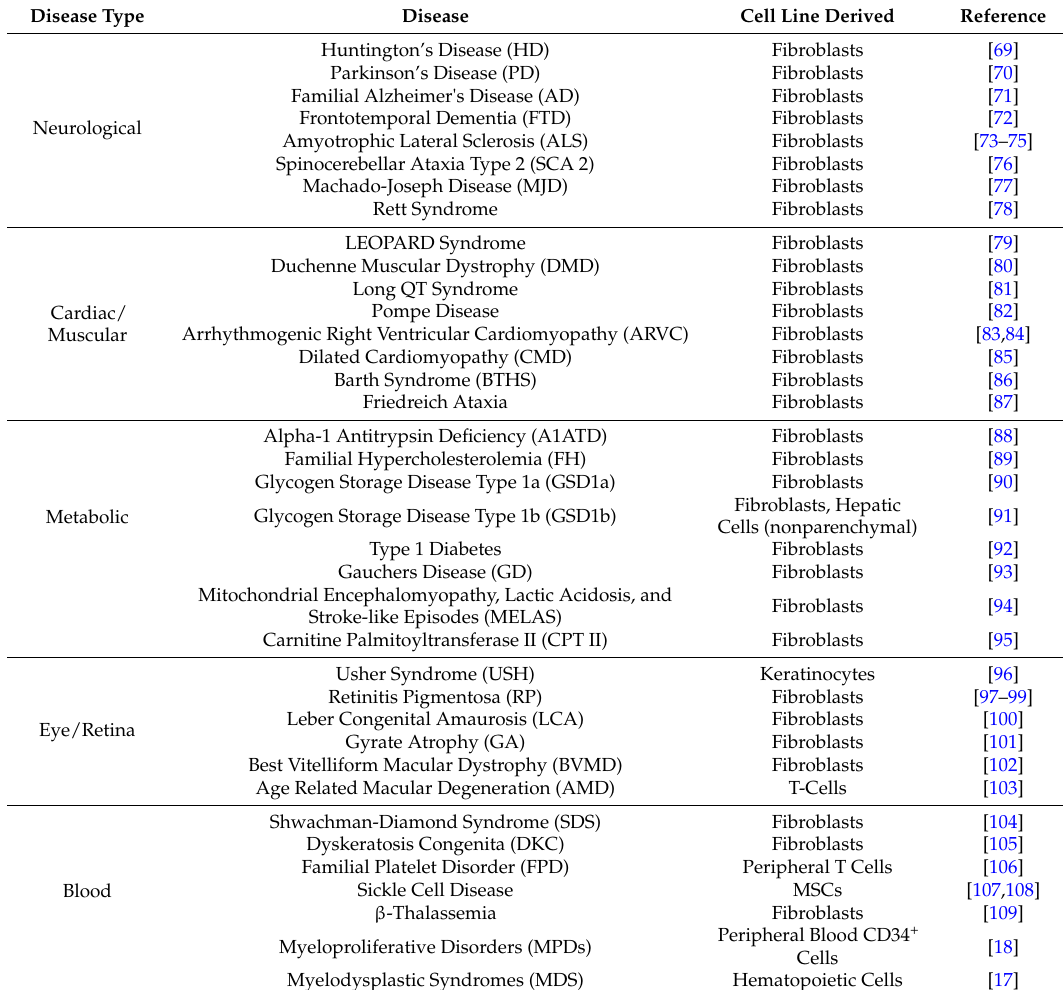
Table 1. Examples of current, established iPSC lines derived from patient-specific somatic cells that recapitulate various disease